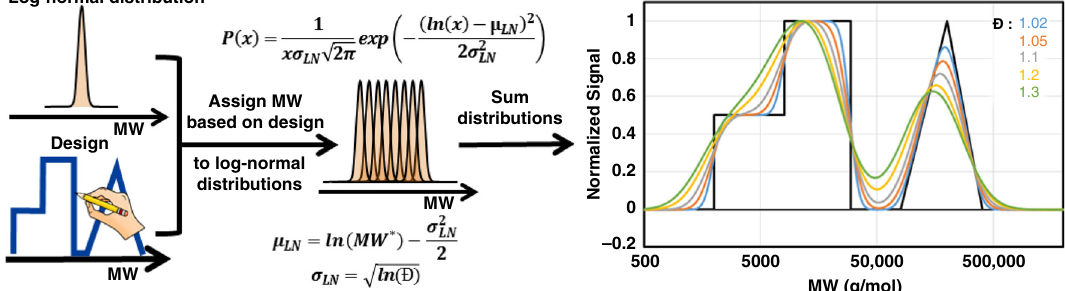
Fig. 8 Overview of mathematical model for the prediction of MWD. The mathematical model inputs the MWD design and generates a large number of log-normal polymer distributions with different MW which are summed to produce the predicted MWD. The is used to study the effect of dispersity on the fi nal MWD. (P(x): log-normal probability density function, x : MW scale; μ : mean of log-normal distribution; σ : standard deviation of log-normal distribution; MW*: linear spaced by weight fraction MW from targeted